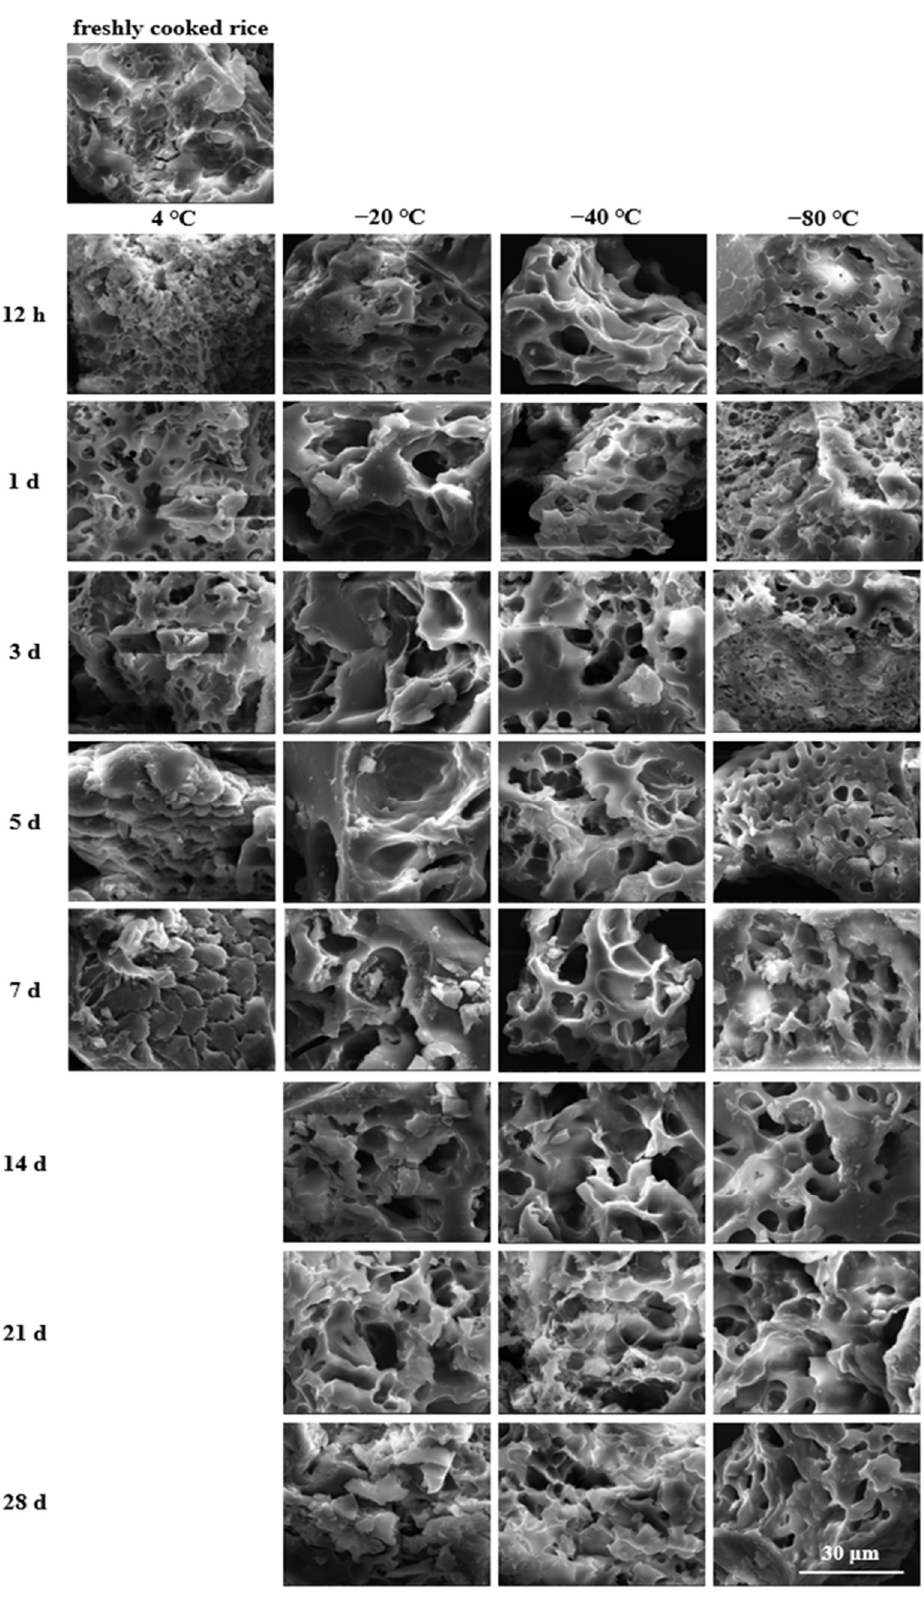
Figure 1. Scanning electron microscopic images of cooked rice samples at different storage tempera- tures and periods (5000 × , bar = 30 µ